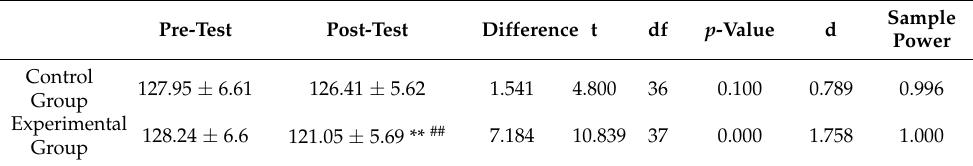
Table 8. Pre/post comparison of PSI-4-SF for two